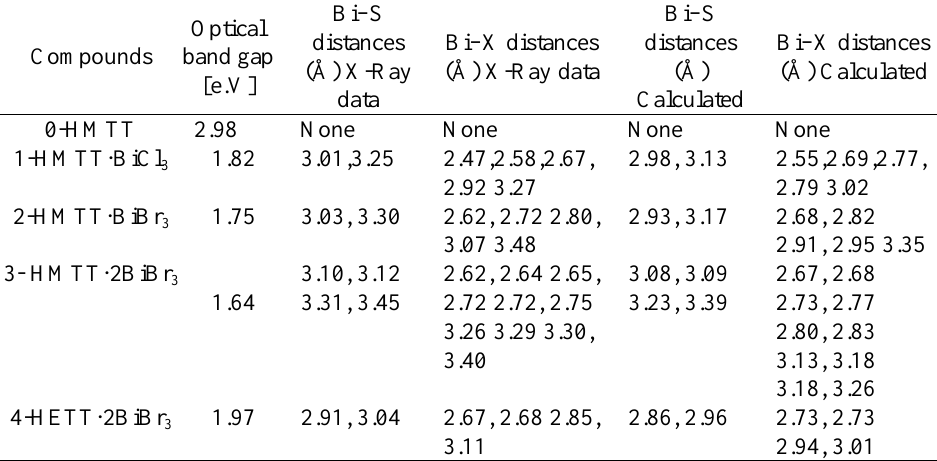
Table 1. Structural and electronic parameters of all described compounds